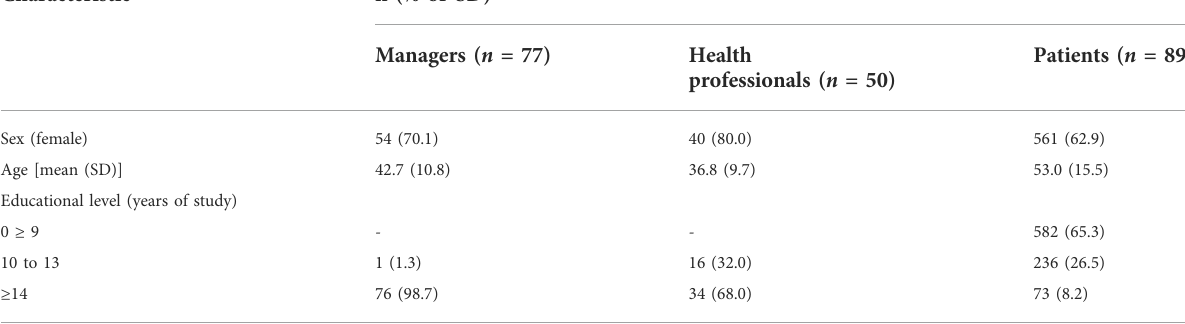
TABLE 1 Sociodemographic pro fi le of study participants. MedMinas Project, 2019.